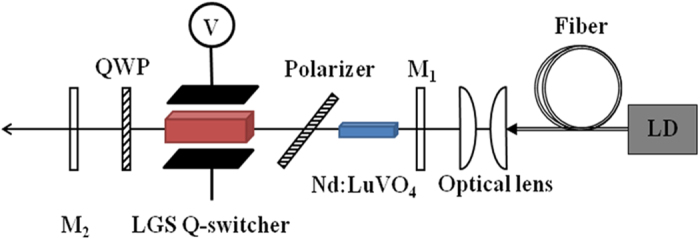
Experimental setup of the LGS electro-optic Q-switched Nd:LuVO4 laser.